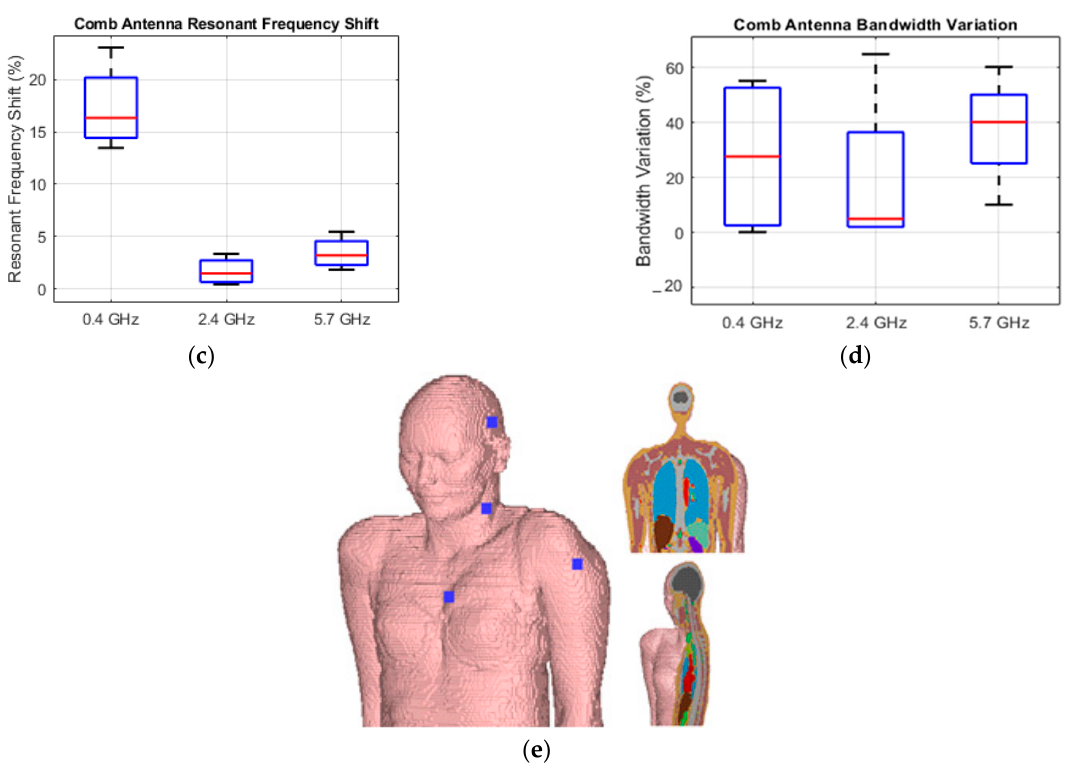
Figure 5. Performance comparison of the meandered and comb antennas for different placements of the antennas in the human voxel model and in the three ‐ layer phantom model. ( a ) Meandered antenna’s resonant frequency alteration percentage at each frequency band ( b ) Meandered an ‐ tenna’s bandwidth alteration percentage at each frequency band ( c ) Comb antenna’s resonant fre ‐ quency alteration percentage at each frequency band ( d ) Comb antenna’s resonant frequency alter ‐ ation percentage at each frequency band, and ( e ) Positions of antenna’s placement in the human voxel.